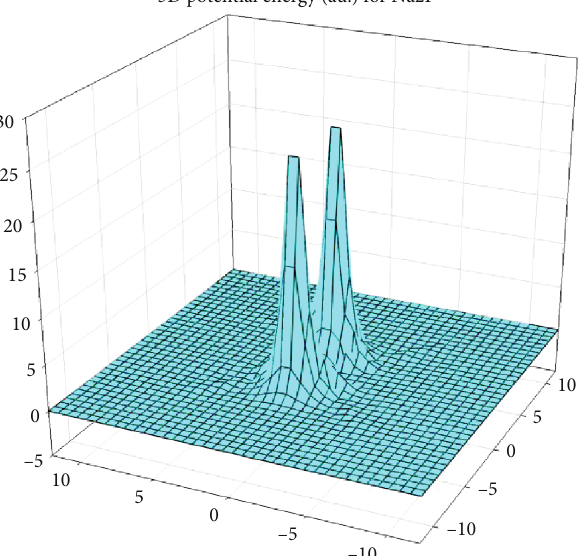
Figure 5: PES for the Na-Na-F (angle θ = − 0 ° ~ 360 ° ).